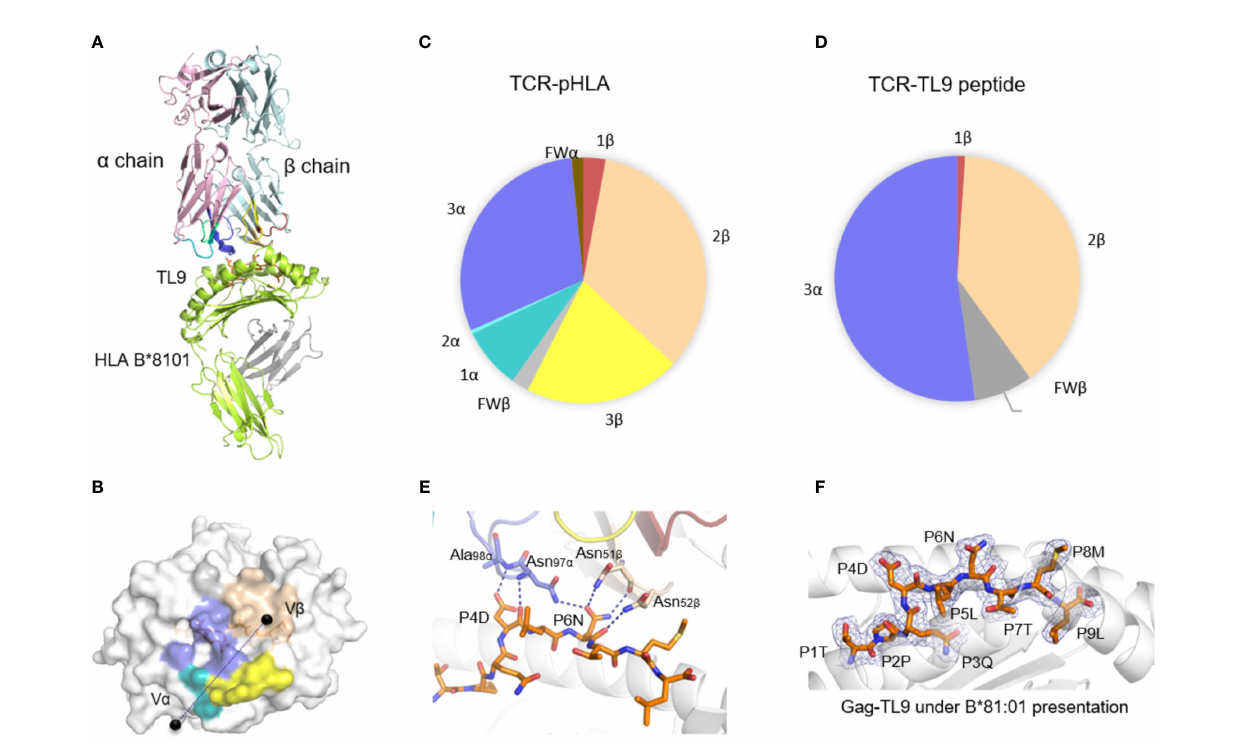
FIGURE 1 | The structure of T18A TCR/HLA-B*81:01/TL9 complex. (A) The T18A TCR (T18A a in pale pink, T18A b in pale cyan) recognize TL9 epitope presented by HLA-B*81:01. (B) The footprint of T18A TCR on the surface of HLA-B*81:01-TL9 complex. (C P Pie charts show the contribution of TCR segments toward the pHLA complex. (D) Interactions of TCR towards peptide. (E) Detailed interactions of T18A TCR with Gag-TL9 epitope in the context of HLA-B*81:01. Blue dashes denote hydrogen bonds; peptide amino acids are indicated in single-letter abbreviations and TCR residues are labeled in three-letter abbreviations. The colors correspond to TCR segment showed in pie chat. (F) Re fi ned maps (2Fo-Fc) of the peptide in HLA-B complexes. The HLA molecules are represented in cartoon, and the peptides are represented as